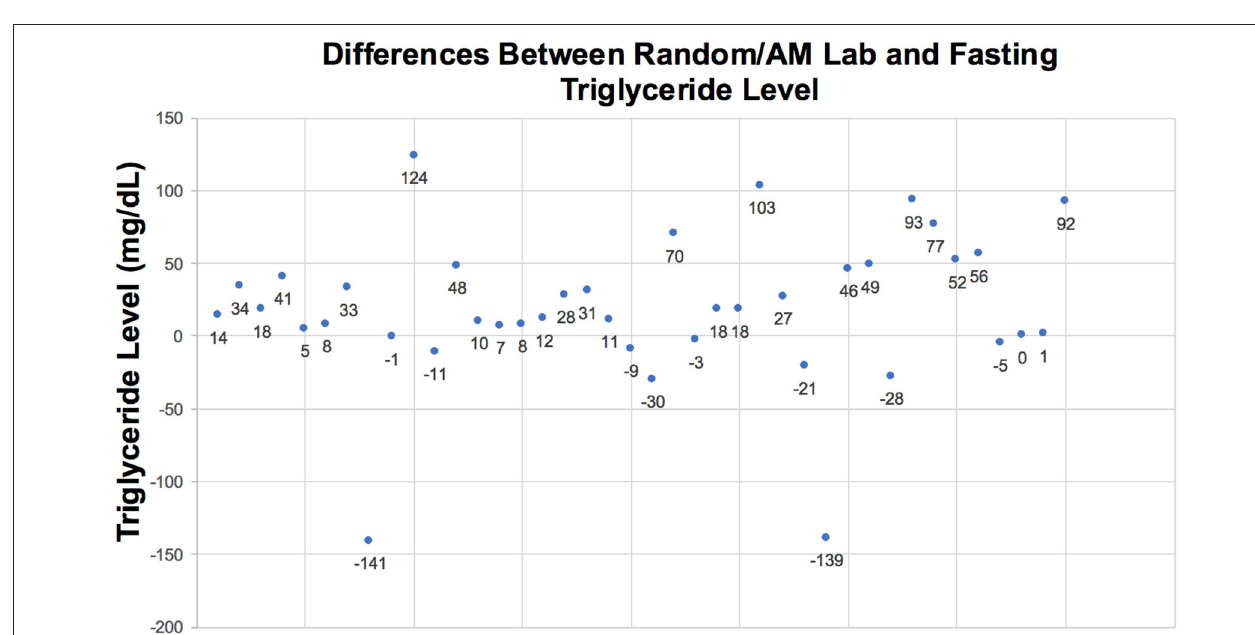
FIGURE 2 | Difference between all non-fasting and fasting TG levels at 2 and 3g/kg/day.